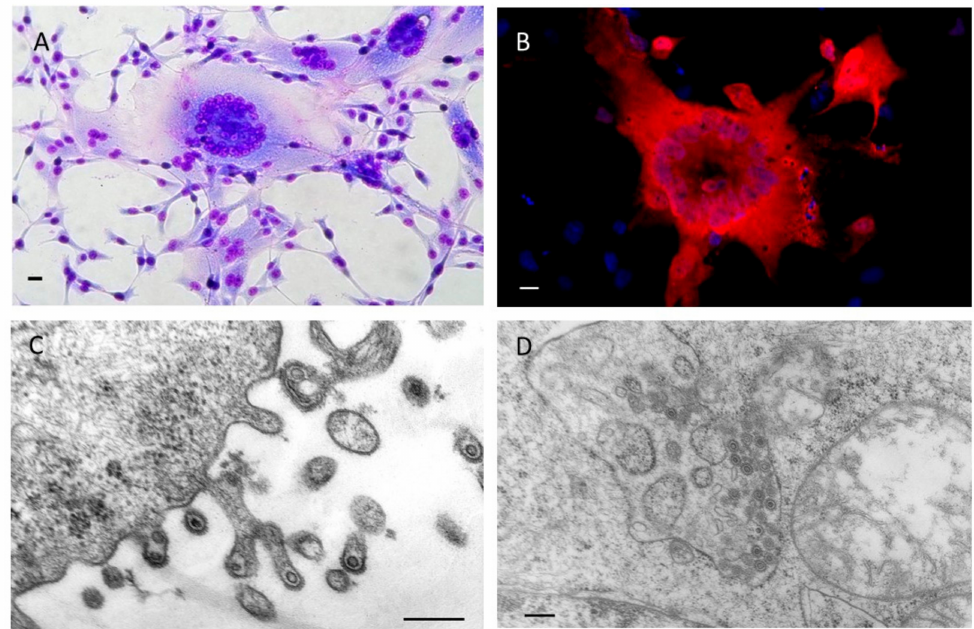
Figure 3. BFV100-infected canine fetal thymus Cf2Th cells: ( A ) Giemsa stained syncytia; ( B ) detection of BFV Gag proteins (red) by indirect immunofluorescence, nuclei were stained in blue; BFV particles budding from the ( C ) plasma membrane (magnification is 60,000-fold) and ( D ) accumulating intracellularly in the endoplasmic reticulum (magnification is 32,000-fold) as visualized by transmission electron microscopy. Scale bars in ( A , B ) are 250 µ m and in ( C , D ) 500